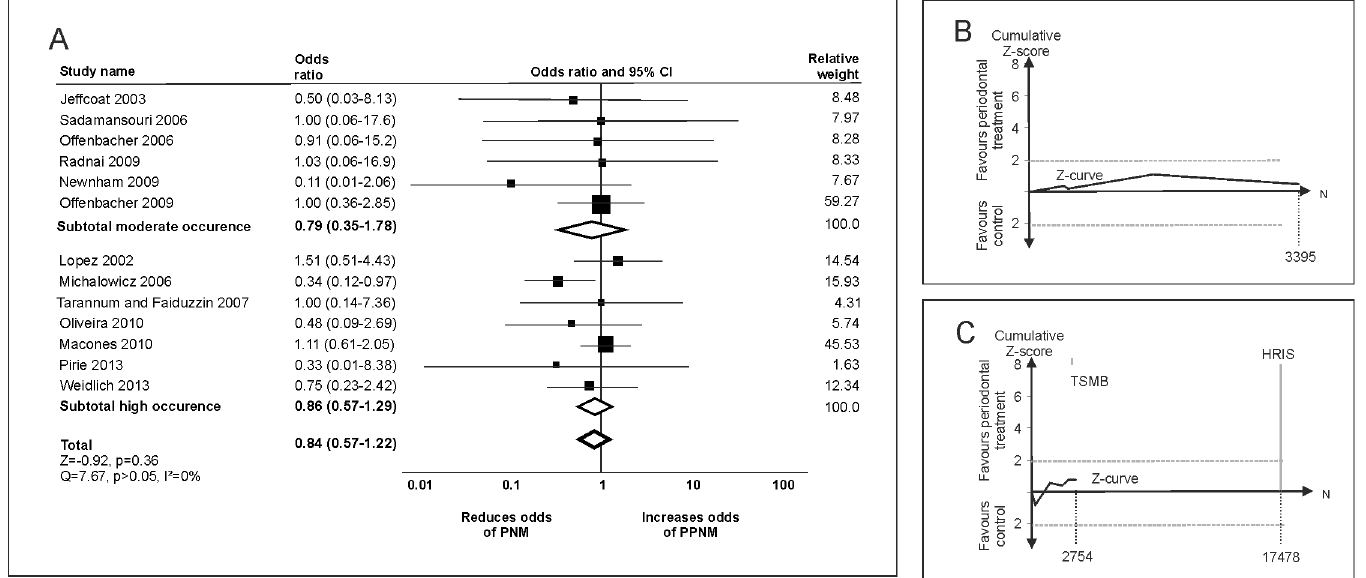
Fig 3. Periodontal treatment and perinatal mortality (PNM). (A) Conventional meta-analyses were conducted to analyze the effect of periodontal treatment for populations with moderate ( < 1%) and high occurrence ( (cid:1) 1%) of PNM as well as in the total population. (B) and (C) Trial sequential analyses of trials in populations with moderate and high occurrence of PNM, respectively. The conventional boundary, the trial sequential monitoring boundary (TSMB) for benefit, the TSMB for futility, and the HRIS are not reached.